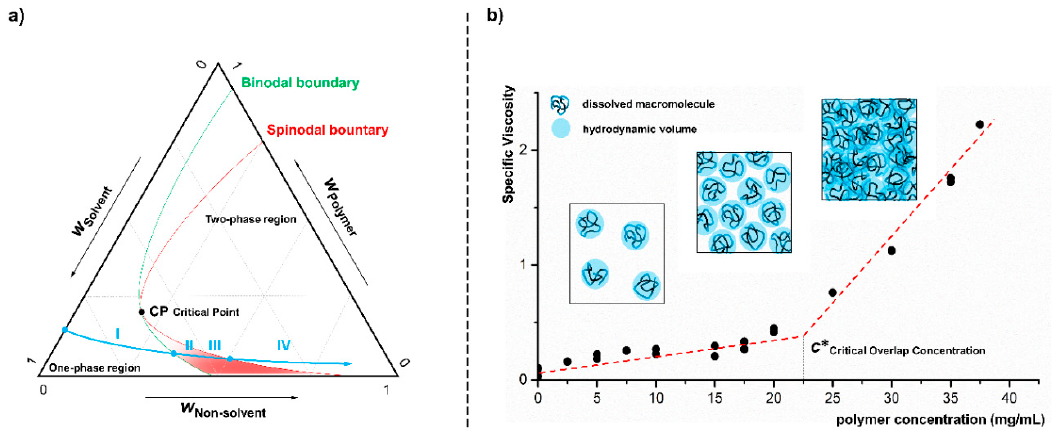
Figure 1. Schematic illustration of a ternary phase diagram ( a ) of polymer, solvent and non-solvent (mass fraction: w i ) declares the addition of a non-solvent to a polymer solution. The blue arrow points to the transfer from a one phase region (I) into the two phase region (IV), thereby crossing both, the spinodal and binodal boundaries shown in green and red line-color, respectively. The graph ( b ) shows the determination of critical overlap concentration ( c *) by viscosity measurements supplemented by a schematic depiction of the behavior of solvated polymer chains in the different concentration ranges.